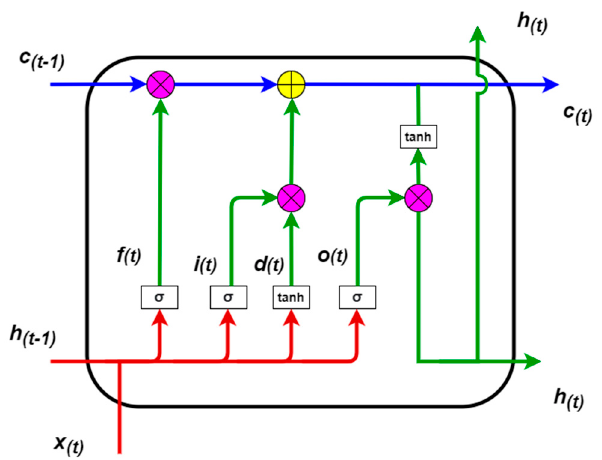
Figure 2. Long short-term memory cell; h ( t − 1 ) is hidden state from previous step, X ( t ) is current input, h ( t ) is new hidden state, c ( t − 1 ) is memory cell internal state, c ( t ) is new memory cell internal state, f ( t ) is forget gate, i ( t ) is input gate, d ( t ) is input node, o ( t ) is output gate, σ is sigmoid function, tanh is hyperbolic tangent function; descriptions are based on [9].